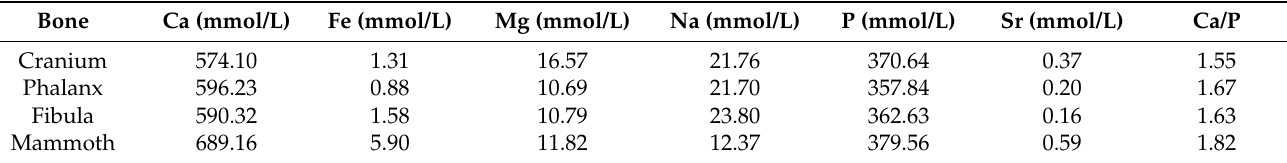
Table 4. Elemental composition of bones samples measured by